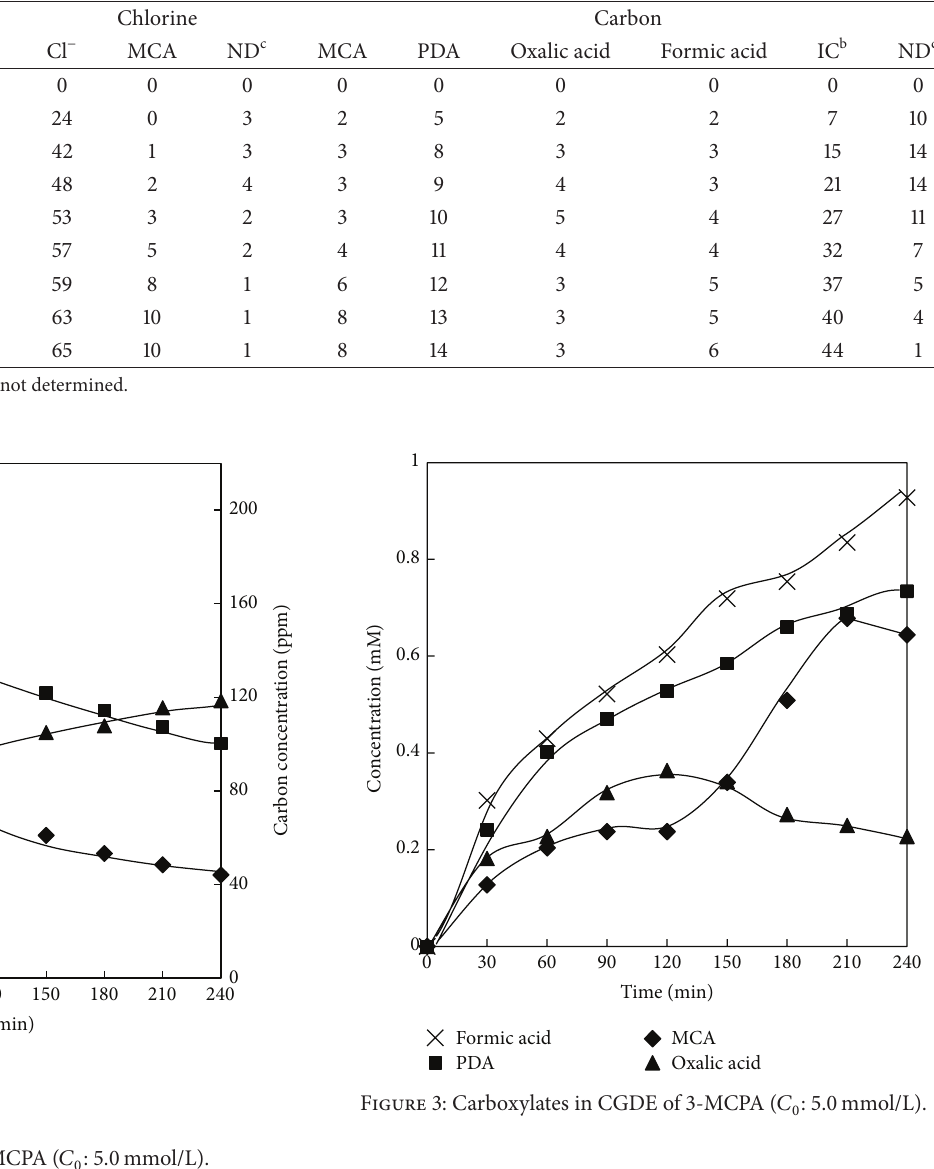
Figure 2: CGDE of 3-MCPA ( 𝐶 0 : 5.0 mmol/L).